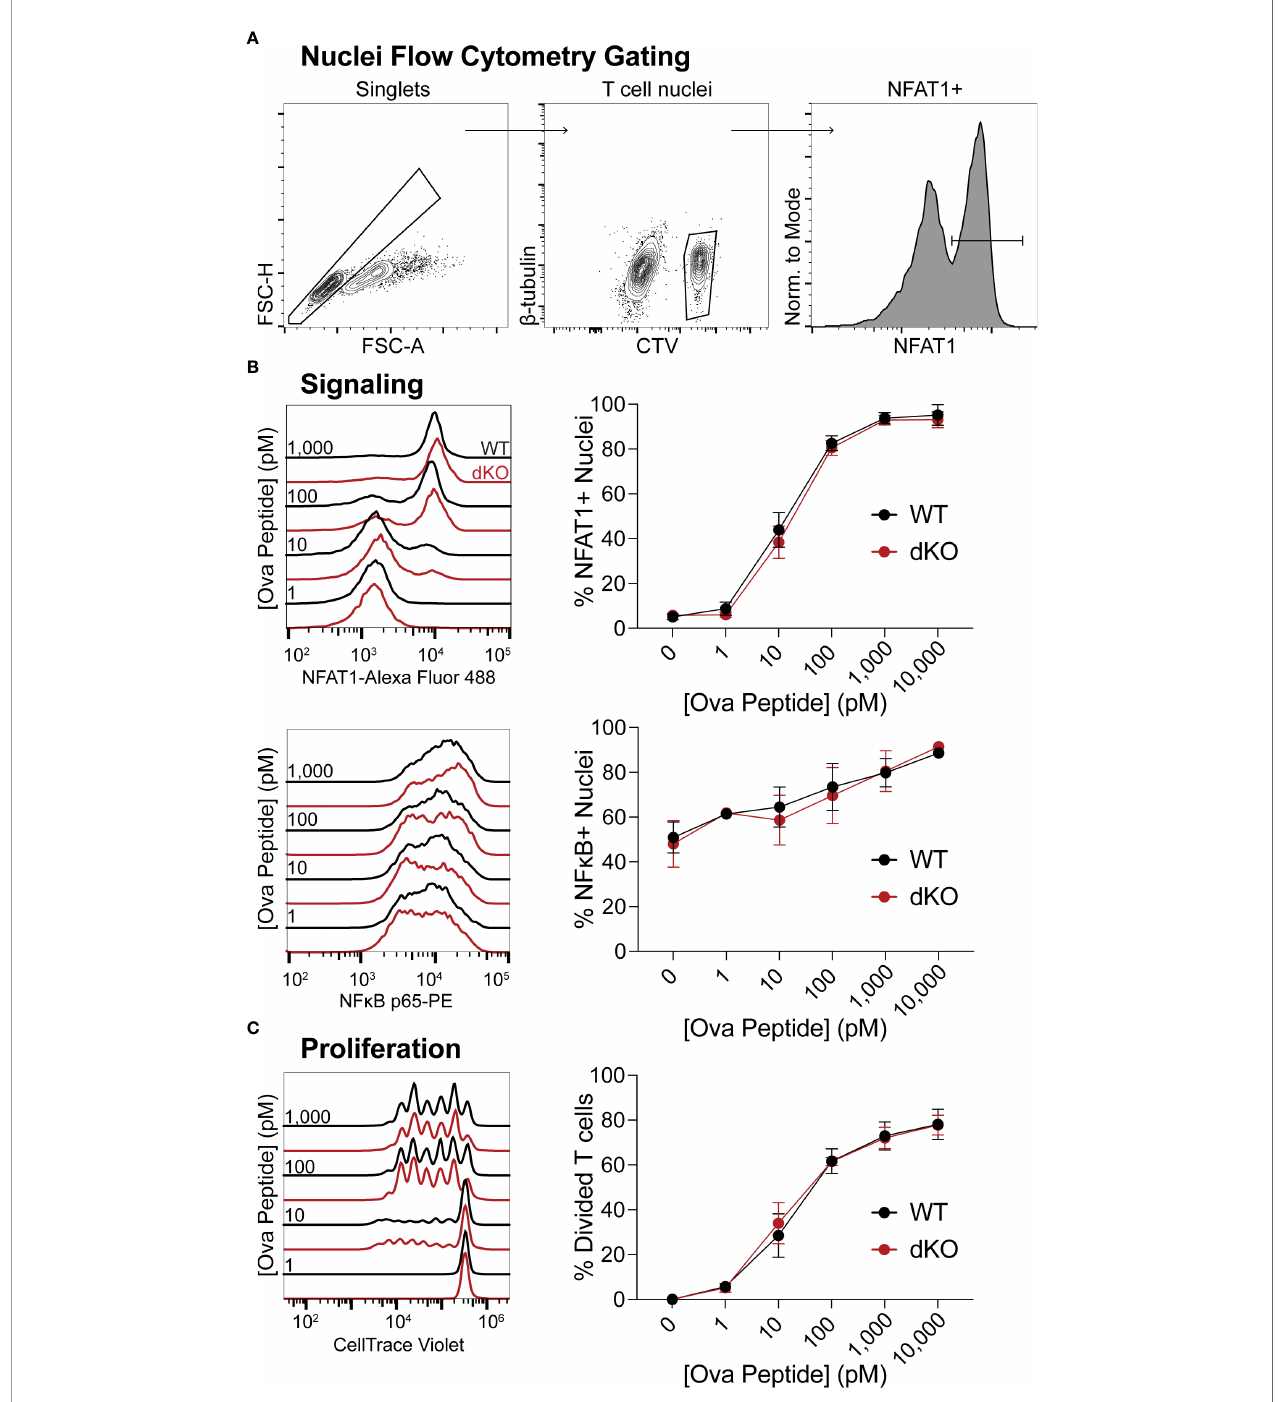
FIGURE 4 | EVL/VASP-de fi cient T cell signaling and proliferation in vitro are normal. Naïve WT and EVL/VASP dKO OT-I T cells were CTV dye-labeled, mixed with antigen-pulsed WT splenocytes, centrifuged, and cocultured. (A) Representative fl ow cytometry gating scheme used to identify isolated T cell nuclei in (B) . (B) T cells were incubated with splenocytes for 45 minutes, and nuclei were isolated for analysis of nuclear translocation of transcription factors by fl ow cytometry. Left: Representative histograms of NFAT1 (top) or NF k B (bottom) fl uorescence in WT and EVL/VASP dKO T cell nuclei. Right: Dose response plots of the percentage of NFAT1+ (top) or NF k B+ (bottom) T cell nuclei. (C) T cells were cocultured with SIINFEKL-pulsed splenocytes for 3 days, and proliferation was assessed by CTV dye dilution. Left: representative histograms of CTV dilution; right: dose response plot shows quanti fi cation of % of T cells divided. Data shown are means ± SEM; averaged from ≥ 3 experiments each with ≥ 3 replicates per group. There was no signi fi cant difference between WT and EVL/VASP dKO T cells, as assessed by two- way ANOVA interaction